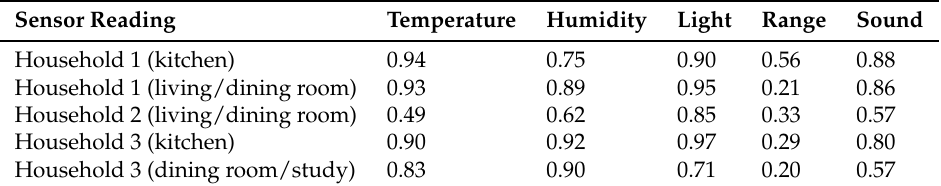
Table 6. Pearson correlation between the readings from pairs of sensors placed in the same room. Sensor